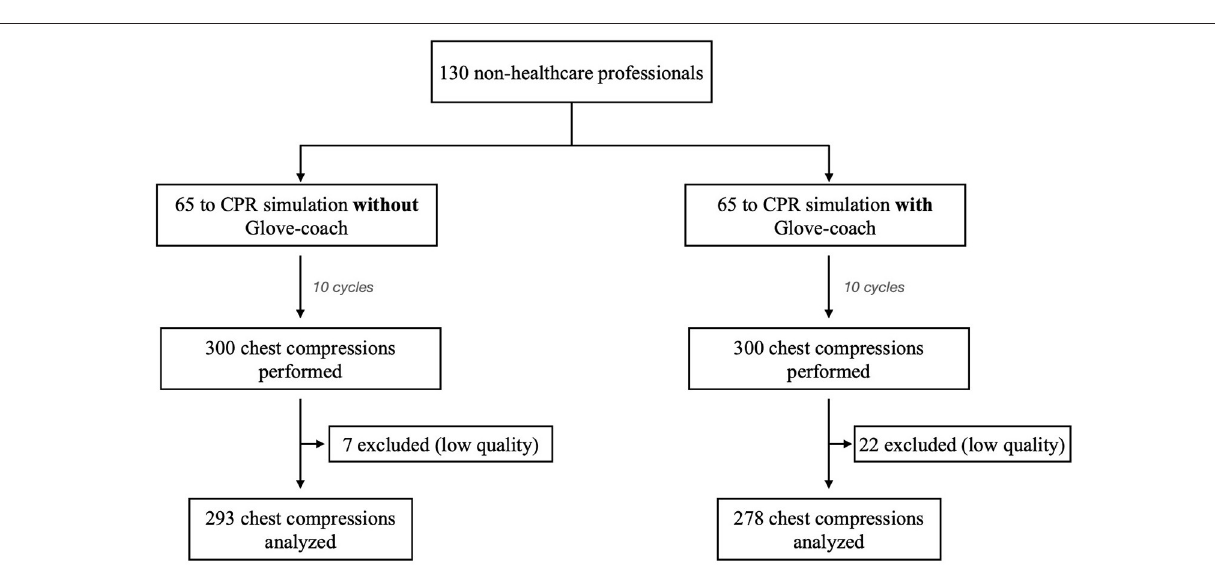
rate was on average above the recommended threshold of 100 rpm. The percentage of compression cycles with an appropriate rate ( > 100 rpm) was 92.4% (min–max 87–100%) in the glove group vs. 71% (min–max 35–100%) in the control group,